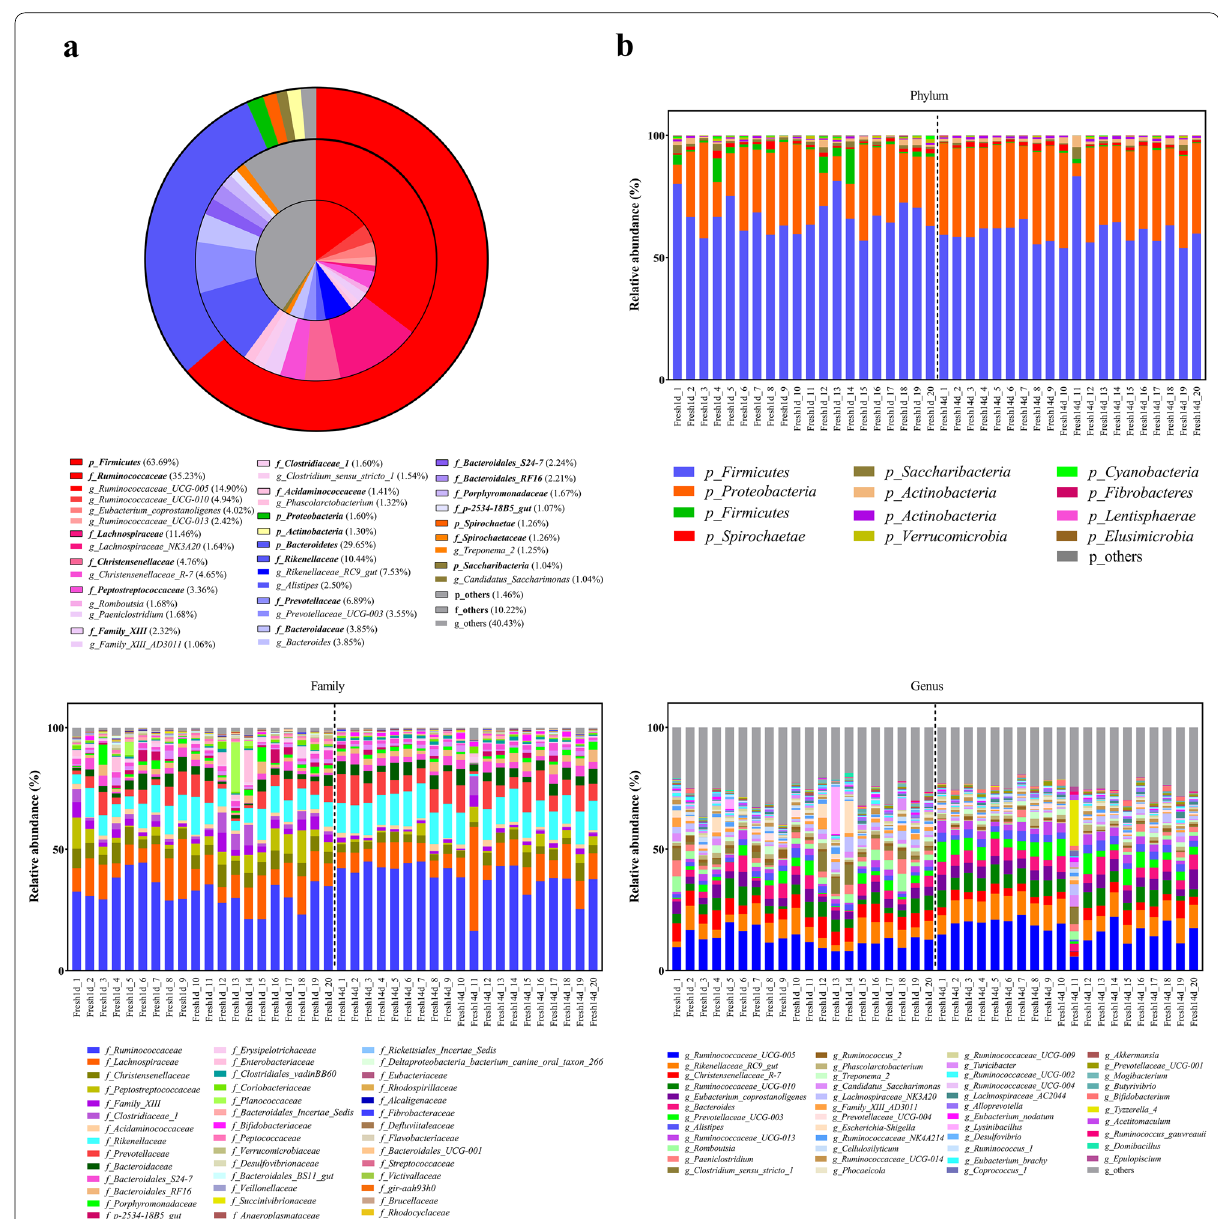
Fig. 2 The relative abundance of fecal samples at the phylum, family and genus level. a Distribution of predominant phyla, family and genera of all fecal samples (relative abundance > 1% at all samples). b The fecal bacterial community composition of all animals at the phyla, family and genus level (relative abundance > 1% at least one sample). Fresh1d indicates fecal microbiota samples from cows on d1, Fresh14d indicates fecal microbiota samples from cows on